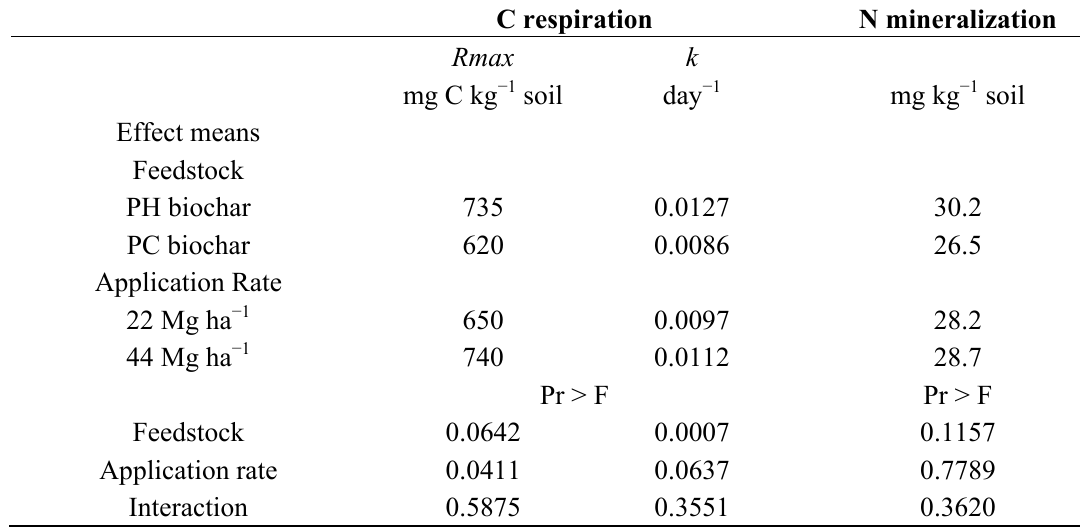
Table 3. Effect means and probabilities of estimated maximum respired carbon ( rmax ), − -N from 136-day respiration study. rate ( k ), mineralized NH 4+ -N, and NO 3